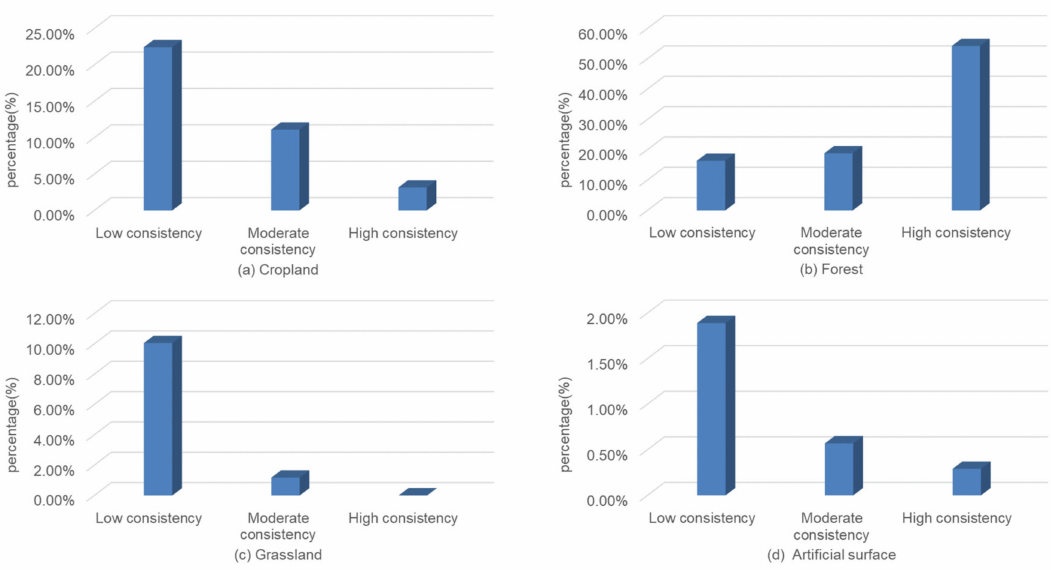
Figure 7. Percentage of consistent areas of major land cover types in the study area: ( a ) cropland, ( b ) forest, ( c ) grassland, and ( d ) artificial